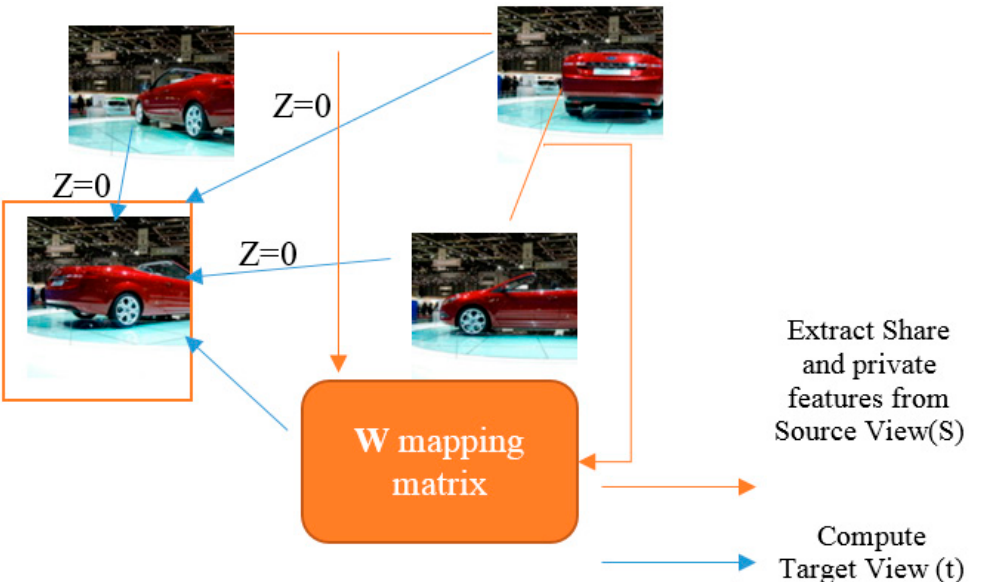
Figure 5. Extracting the features from source pictures and creating the target view (image retrieved from the public dataset IXMAS).